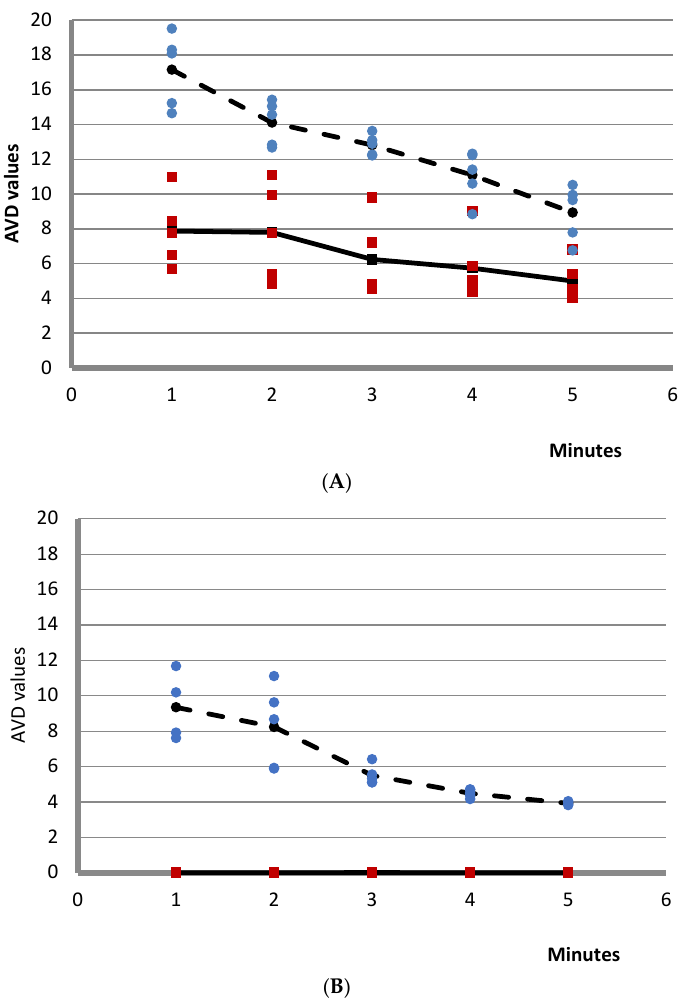
Figure 6. AVD values of the red laser and IR laser over time. ( A ) Drying of the red paint by red laser (red marks) and by IR laser (blue marks). ( B ) Drying of the green paint using the red laser (red marks) and using the IR laser (blue marks).